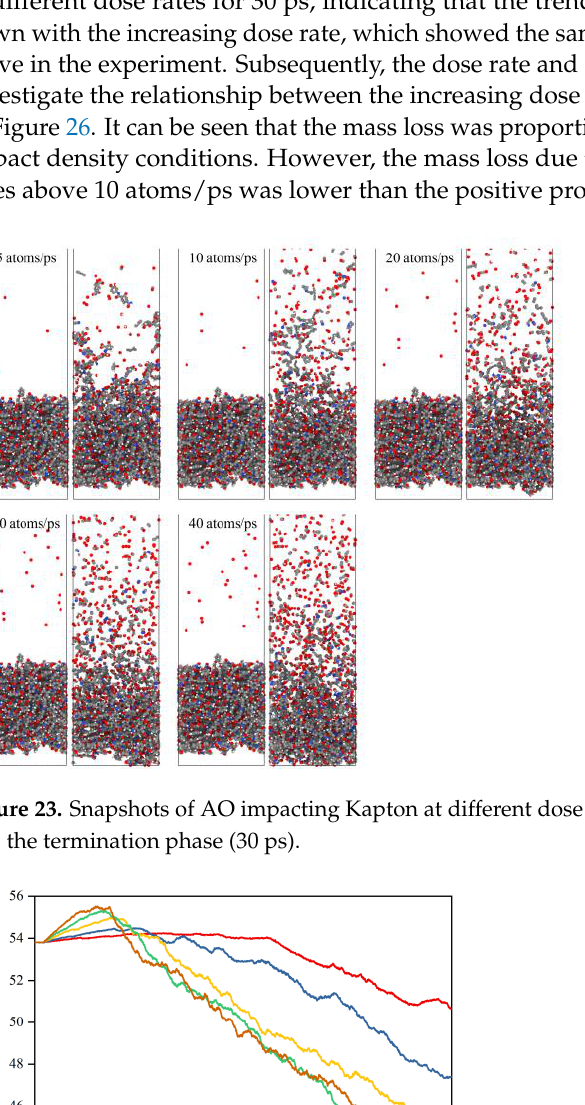
Figure 25. Mass loss of the Kapton during atomic oxygen impact at different dose rates. Figure 26. Normalized mass loss of the Kapton during atomic oxygen impact at different dose rates. To investigate the effect of a high impact frequency (high dose rate) on the AO effect, the trajectories of the initial phase (5 ps) of the atomic oxygen impact on the material at different dose rates were compared and analyzed. As shown in Figure , the amount of atomic oxygen deposited on the material surface gradually increased with the increasing dose rate, which may have hindered the subsequent contact reaction of atomic oxygen with the material and led to a decrease in the amount of atomic oxygen reacted. In con- trast, the atomic oxygen at lower dose rates was less dense. It could fully interact with the material so that the resulting mass loss would be higher. Subsequent calculations of the erosion yield of single atomic oxygen verified these speculations. Figure 28 shows the proportion of atomic oxygen involved in the reaction. It can be seen that the quantity per- centage of atomic oxygen involved in the reaction decreased at dose rates higher than 10 atoms/ps. The reason for the non-participation of atomic oxygen in the reaction may be